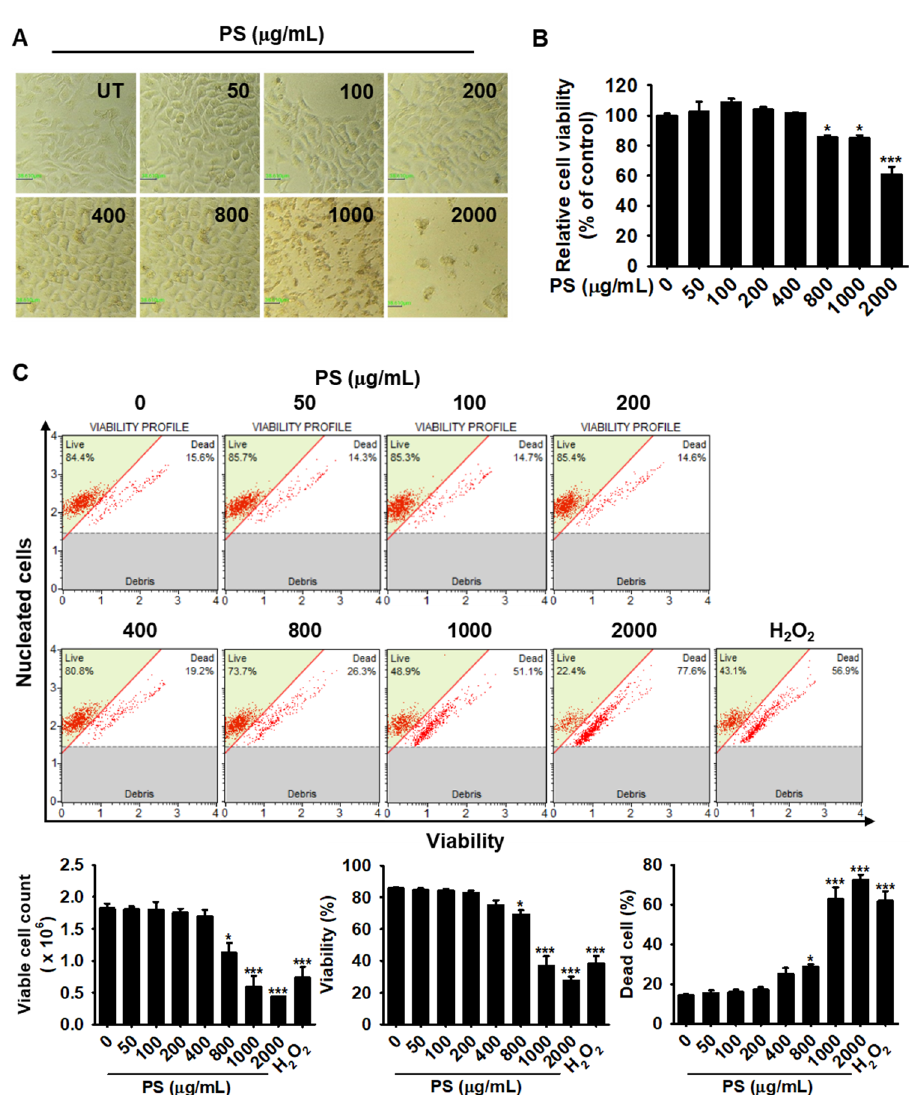
Figure 1. High concentrations of PS exert cytotoxic e ff ects in HaCaT keratinocytes. HaCaT keratinocytes were seeded at a density of 1 × 10 4 cells / mL and treated with PS at the indicated concentrations (0–2000 µ g / mL) for 24 h. ( A ) Morphological changes were observed by using a phase-contrast microscope (10 × ); ( B ) In a parallel experiment, after treatment with PS for 24 h, MTT was added to the cells and incubated for 4 h at 37 ◦ C, and cell viability was measured relative to the untreated control. ( C ) Under the same experimental conditions, viable cell count, viability, and dead cell populations were assessed by flow cytometry using a Muse ® Cell Viability Kit. H 2 O 2 (1000 µ M) was used as a positive control for the induction of apoptosis. Significant di ff erences among the groups were determined using the one-way ANOVA followed by using Bonferroni correction. All data were averaged from three independent experiments and are presented as the mean ± the standard error of the median [*** p < 0.001 and * p < 0.05 vs. the untreated group (UT)]. Scale bars = 40 µ